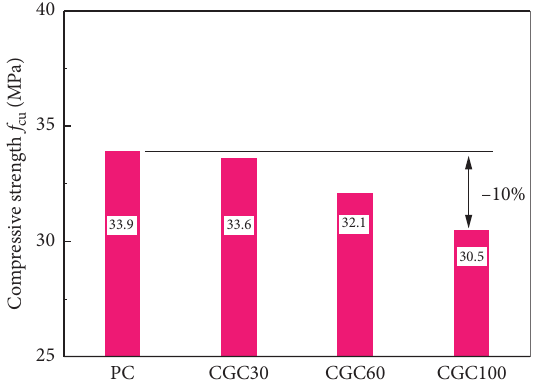
Figure 3: Comparison of the compressive strength.